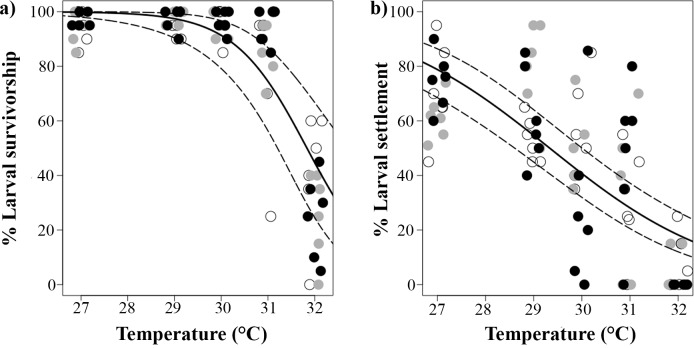
a) Percentage larval survivorship 5 days after fertilization for Acropora tenuis reared under different temperatures and nutrient enrichment [low (open circles), medium (grey circles), high (black circles); Experiment 1c]. b) Settlement rates for larvae of A. tenuis that had being fertilized, reared and settled under different temperatures and nutrient enrichment (Experiment 1d). Control treatment: ‘low’ nutrient enrichment and at temperature = 27°C. Solid lines indicate fitted GLM trends, while dashed lines are 95% confidence intervals. Individual points are jittered horizontally for clarity.